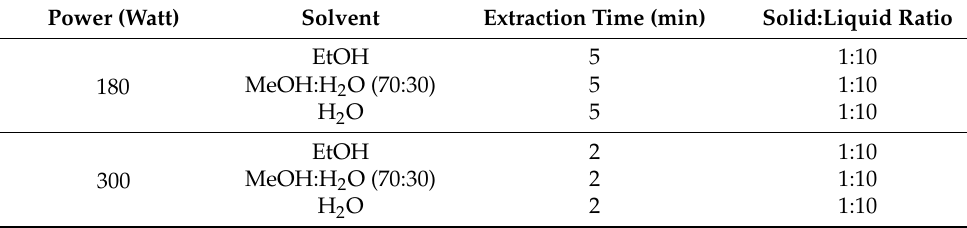
Table 1. Instrumental and process conditions of the MAE extraction